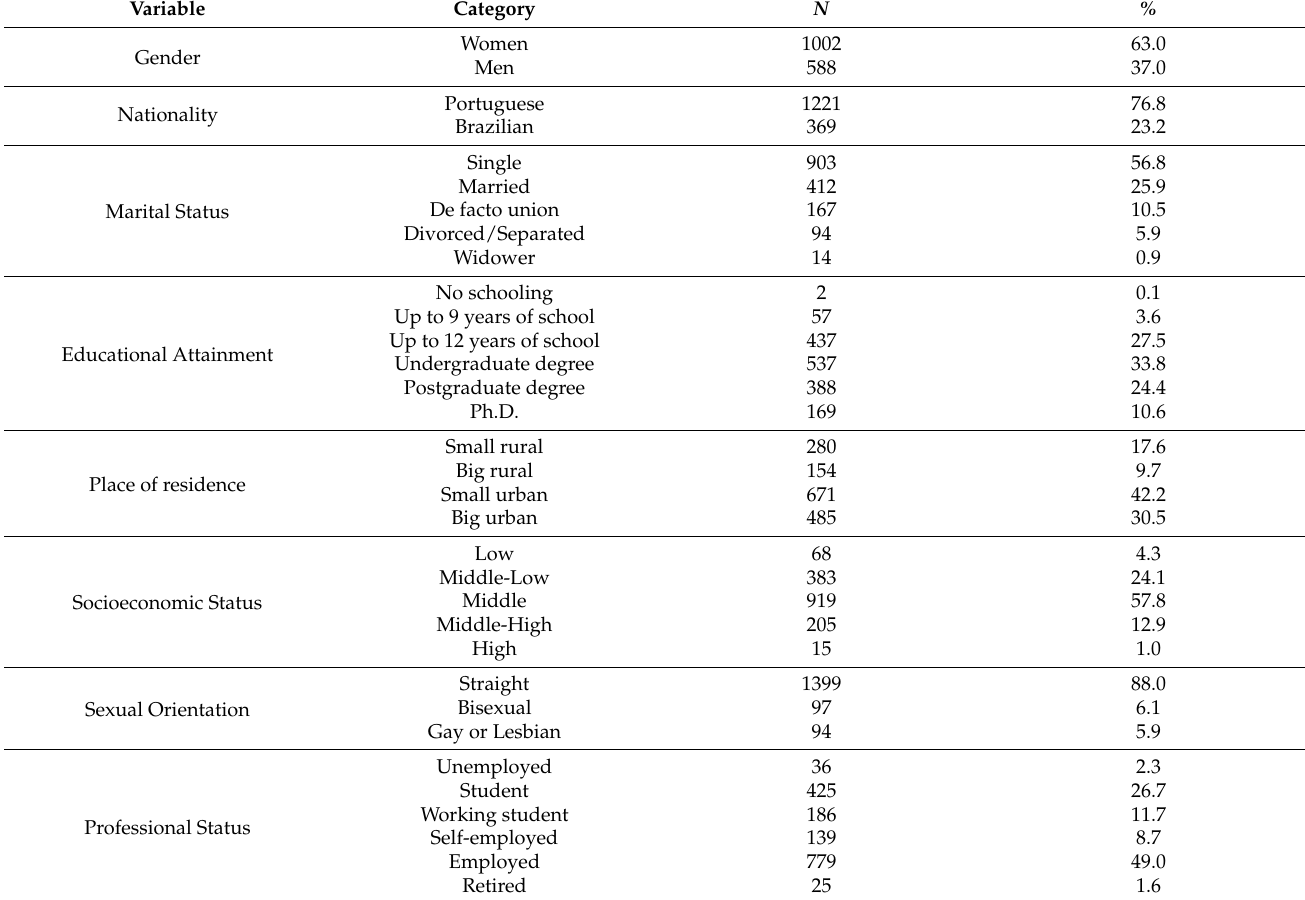
Table 1. Sociodemographic characteristics of the participants ( N = 1590; M age = 33.68; SD =